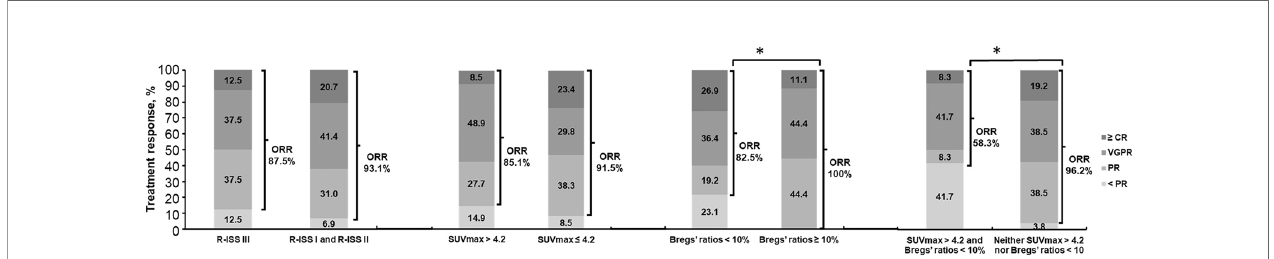
FIGURE 1 | Overall response rates for all patients, by R-ISS III, SUVmax > 4.2, and Bregs ’ ratios < 10% in NDMM. *P < 0.05, determined by the chi square test and the Fisher ’ s exact test. NDMM , newly diagnosed multiple myeloma; ORR , overall response rate (ORR = [complete response (CR) + very good partial response (VGPR) + partial response (PR)); R-ISS , Revised International Staging System; SUVmax , maximum standard uptake value; Bregs , regulatory B cells.